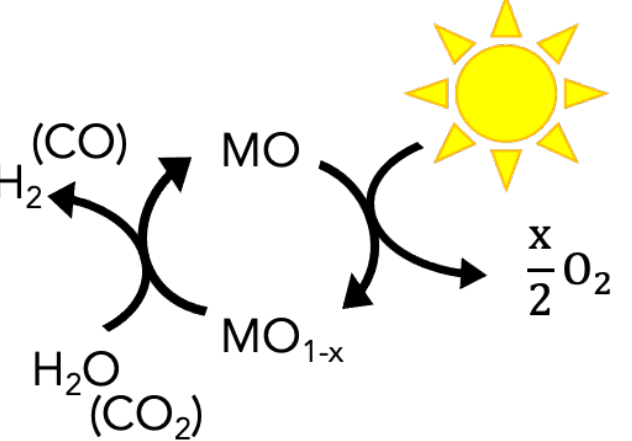
Figure 6. Example of chemical looping-based process for the production of syngas, using metal oxide (e.g., CeO 2 or ZnO) as a catalyst. See the main text and [46,47] for details.